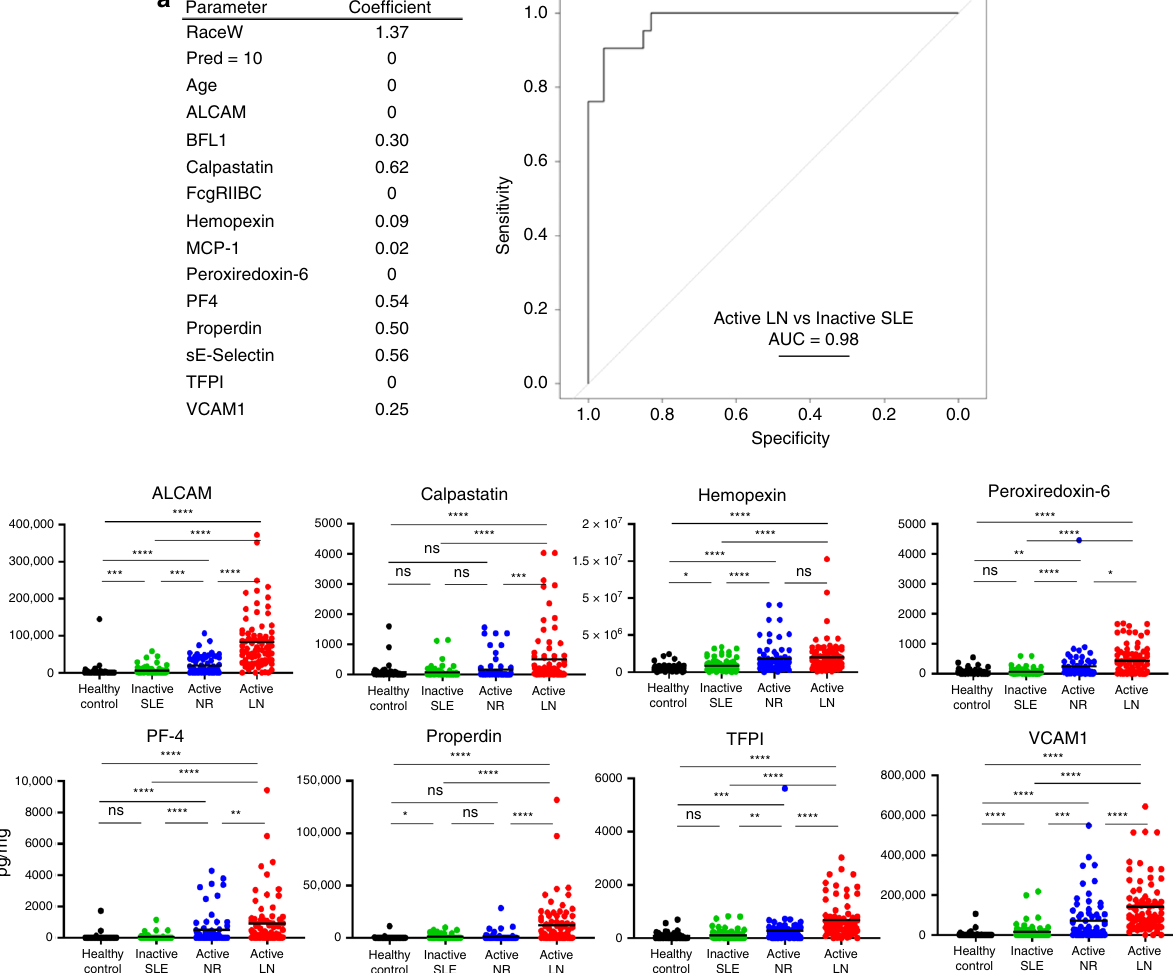
Fig. 3 Testing the utility of multi-marker panels, and validity of markers in other ethnicities. a Lasso Regression Analysis to identify multi-marker panels. We performed Lasso regression analysis to identify multi-marker panels that may better predict active LN status in the primary validation cohort, as detailed in Methods. Besides the 12 urine proteins, we included race, age, and prednisone usage as additional variables. The combination with the best predictive model encompassed 8 of the 12 urine proteins, together with race, but excluded age and prednisone usage. This octuplex panel exhibited outstanding ability to discriminate active LN from inactive SLE with a ROC AUC value of 0.98. b Plotted are ELISA-validation results in a second cohort, comprised of Asian subjects. Each protein was tested using the following sample group: 80 active SLE samples, 80 inactive SLE samples, 67 active non- renal lupus samples, and 53 healthy controls. The plots show the mean concentration in urine for each disease group after normalizing against urinary creatinine. * p < 0.05, ** p < 0.01, and *** p < 0.001, as determined using Mann – Whitney U -test. Source data are provided as a Source Data fi